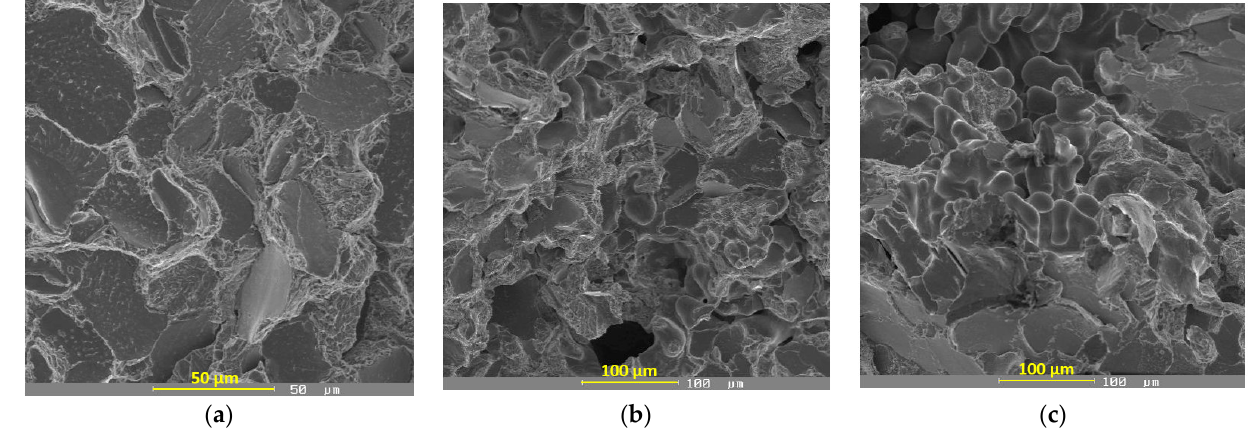
Figure 15. Fractography evaluation of ZnAl4Cu3 alloy: ( a ) after first remelting, P1; ( b ) after third remelting, P3; and ( c ) after ninth remelting, P9. remelting, P3; and ( c ) after ninth remelting, P9.